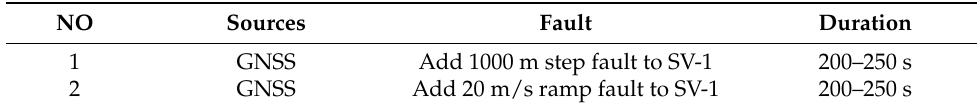
Table 3. Fault scenarios in the navigation